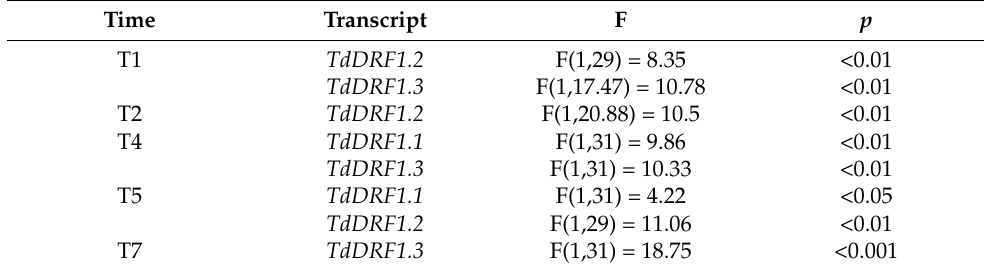
Table 4. ANOVA summery table. Significant differences in TdDRF1 transcripts between FI and RI conditions during the time-course are